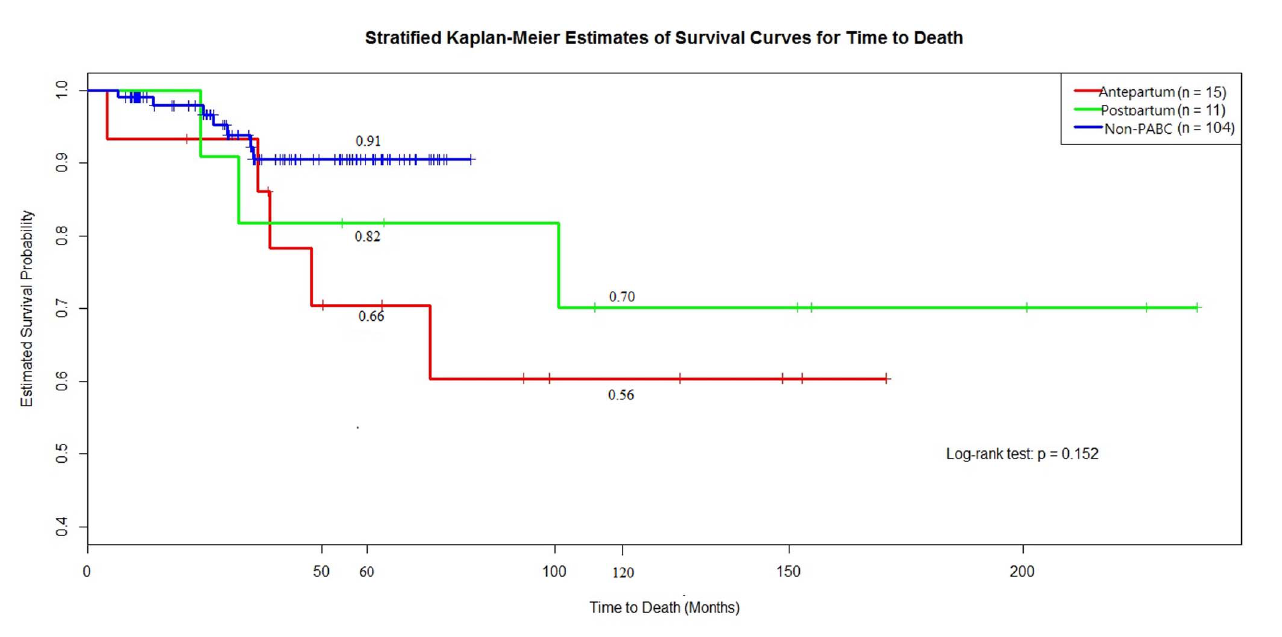
Figure 1. The 5-year survival curve among antepartum PABC, postpartum PABC and non-PABC; 10-year survival curve between antepartum PABC and postpartum PABC. 1. The 5-year survival estimate among three groups, Log-rank test, 0.15. 2. The 10-year survival estimate between PABC two subgroups Log-rank test,